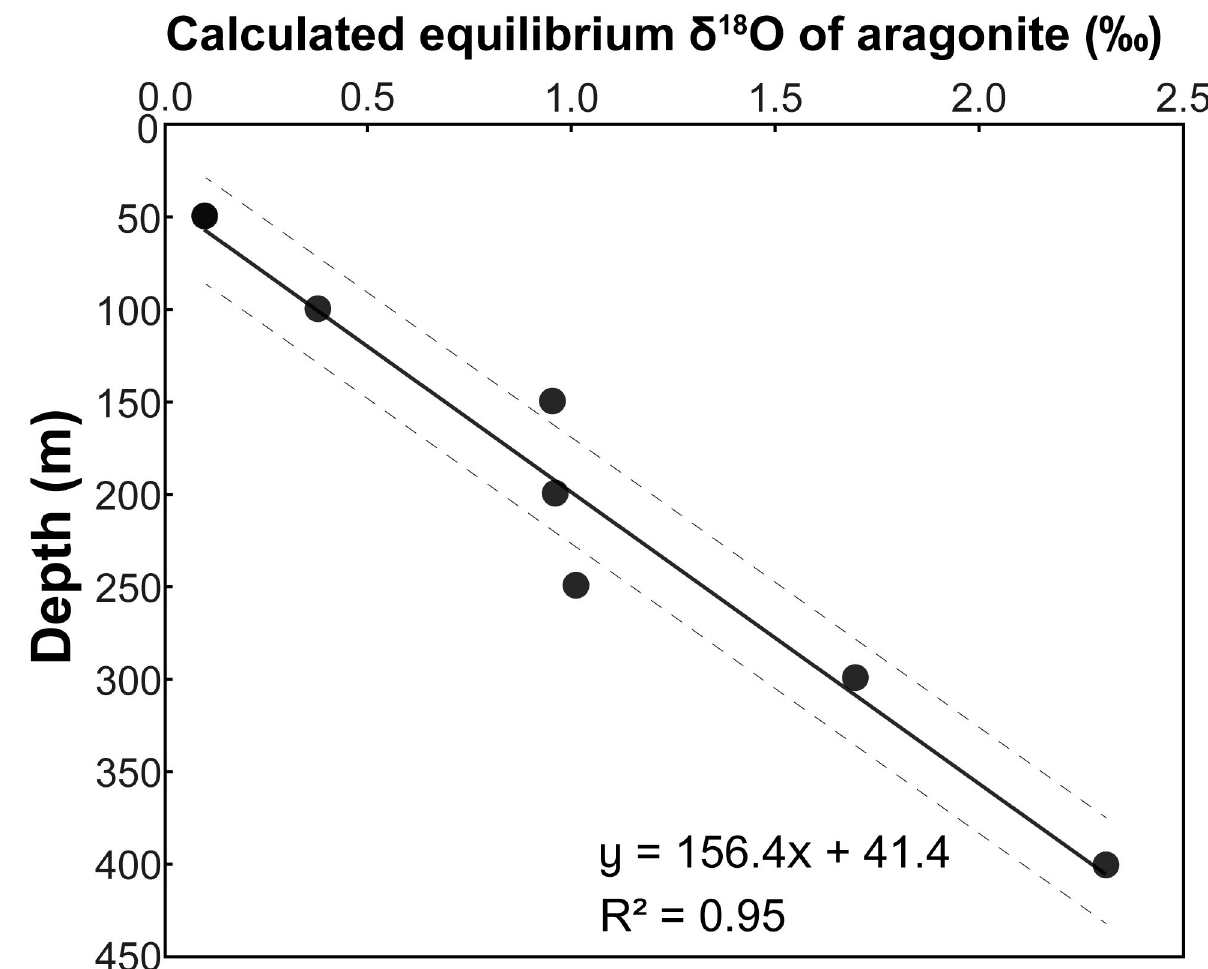
Fig 7. Calculated δ 18 O aragonite vs. depth. Dashed lines indicate the 95% confidence